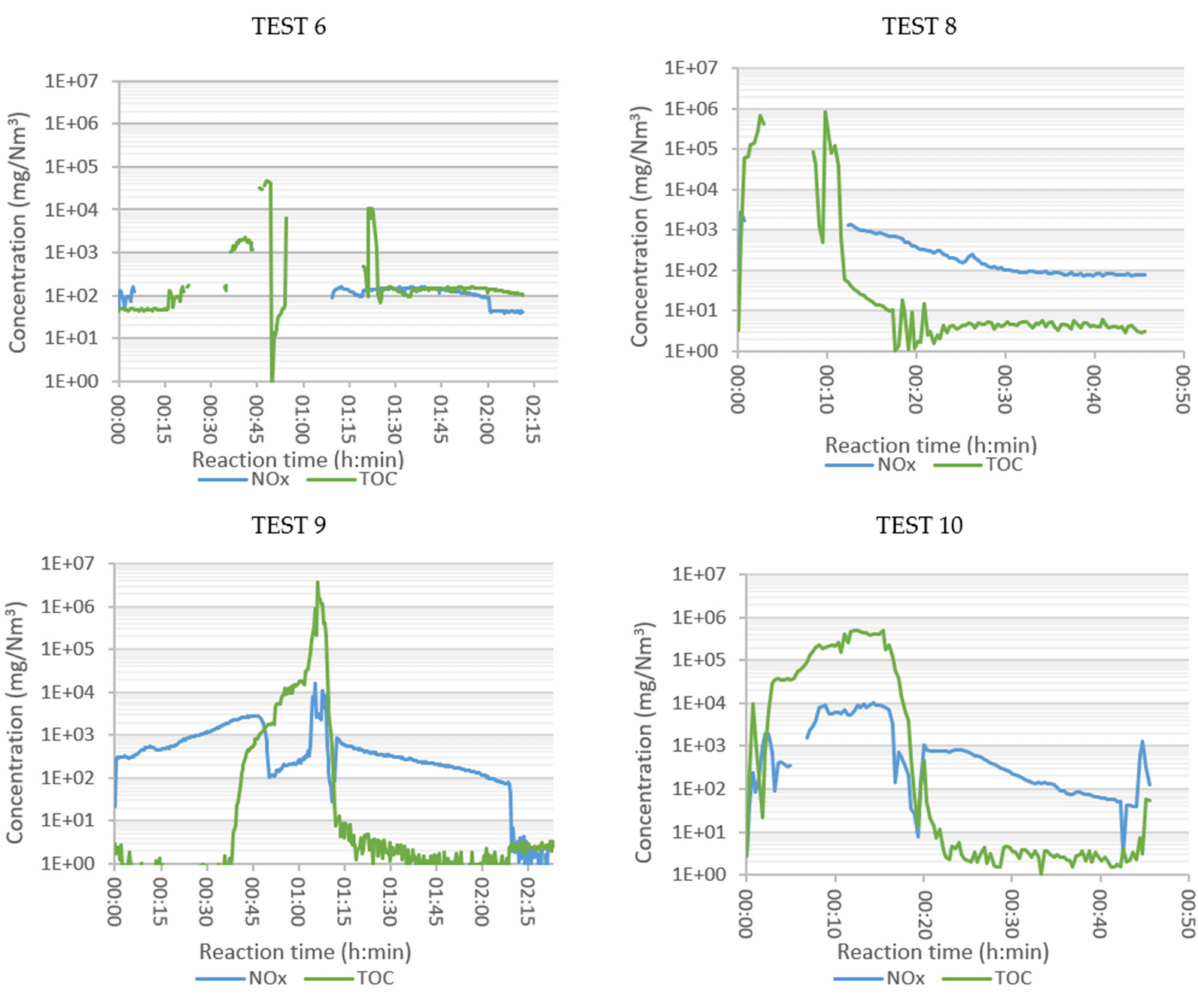
Figure 5. Concentration of Total Organic Compounds (TOC) and NOx (NO and NO 2 ) in the flue gases of combustion of SRF: Test 6 (air, 550 ◦ C), Test 8 (oxygen, 900 ◦ C), Test 9 (air, 900 ◦ C), and Test 10 (enriched air, 900 ◦